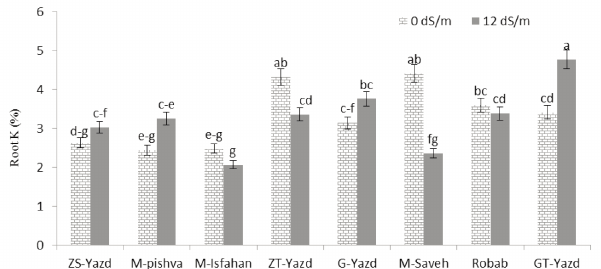
Fig. 10 ­ The interaction effects of water salinity and pomegra­ nate cultivars on root potassium content.